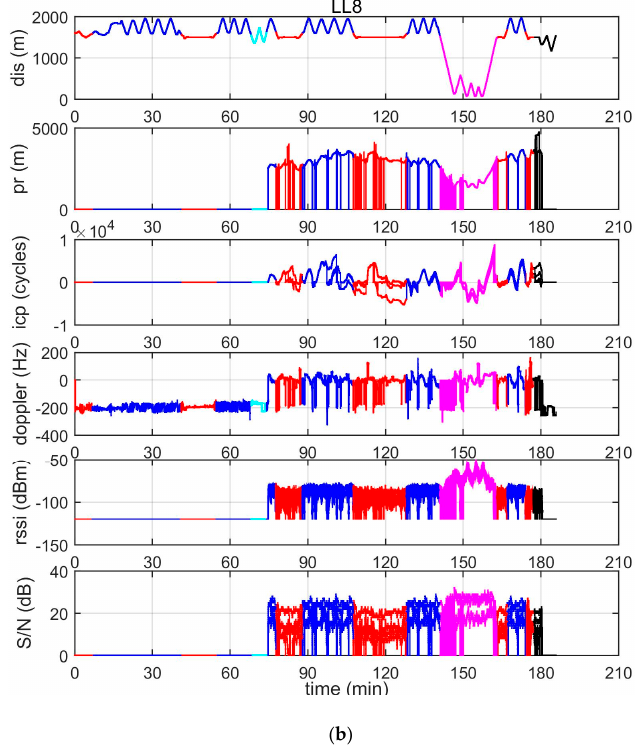
Figure 6. Raw measurements from LL1 ( a ) and LL8 ( b ).